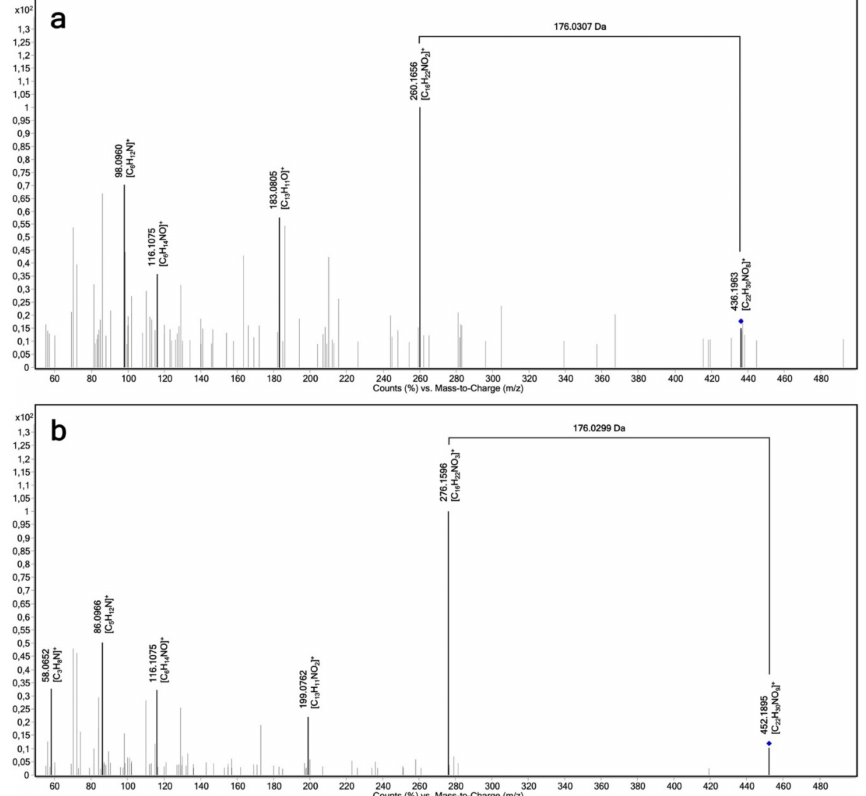
Figure 3. Productionspectrum(LC-QTOF-MS)ofpropranololglucuronideand4-hydroxypropranolol glu- curonide obtained by UGT-dependent biotransformations. ( a ) Propranolol glucuronide, C 22 H 29 NO 8 , [M+H] + theor. = 436.1971, [M+H] + exp. = 436.1963, ∆ m / z = 0.3 ppm; ( b ) 4-hydroxypropranolol glucuronide, C 22 H 29 NO 9 , [M+H] + theor. = 452.1895, [M+H] + exp. = 452.1921, ∆ m / z = 0.1